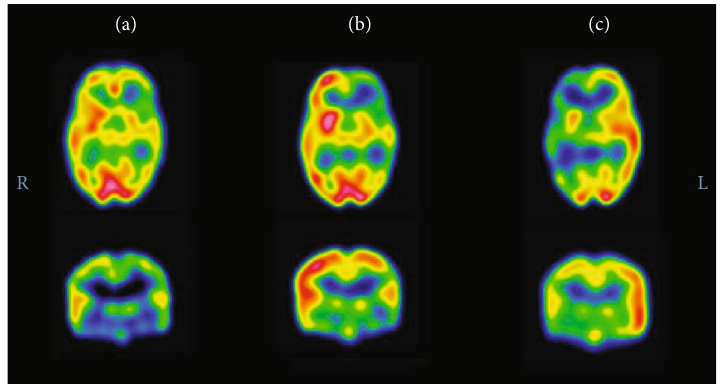
Figure 2: Ictal and interictal SPECT scans in a three-year-old boy with drug-resistant epilepsy. (a) Interictal SPECT showed prominent hypoperfusion over the left frontotemporal region. (b) First ictal SPECT attempt was performed in a seizure of 46-second duration, and radioisotope was injected at 40 seconds from the seizure onset. This was a late injection, and ictal SPECT showed similar fi ndings as to the interictal SPECT. (c) Repeated ictal SPECT attempt was performed in a seizure of nine-second duration, and radioisotope was injected at two seconds from the seizure onset. This was an early injection, and ictal SPECT showed a relative increase in perfusion in the left frontotemporal region, compared with the right. This demonstrates the signi fi cance of early injection in accurately localizing the seizure onset zone, adapted from Kim et al. [38].